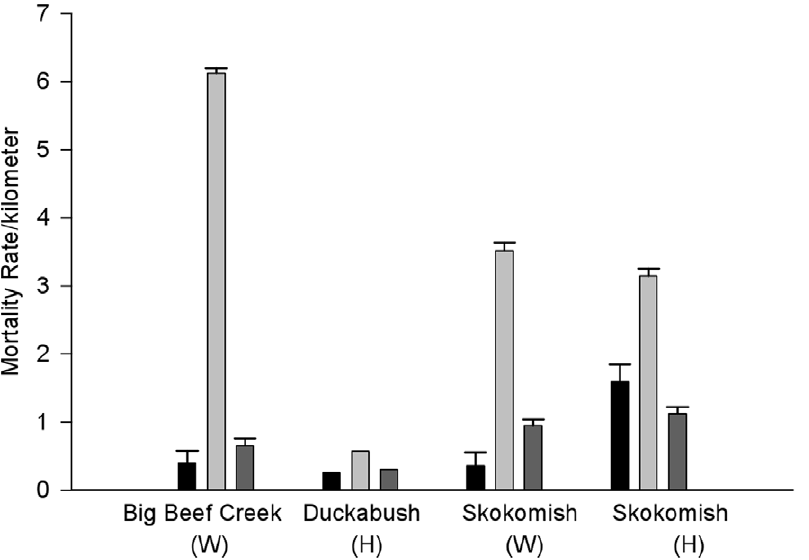
Figure 3. Distance-based instantaneous mortality rate for marine migration segments. Segment- and year specific instantaneous mortality estimates for each tagged group were scaled by the distance of each segment in kilometers (km). Mean rates for 2008, 2009, and 2010 ( 6 SE) are presented by population. Duckabush population rate is for 2009 only. Black bars represent RM-HCB mortality rate, light gray bars represent HCB-ADM mortality rate, and dark gray bars represent ADM-JDF mortality rate.